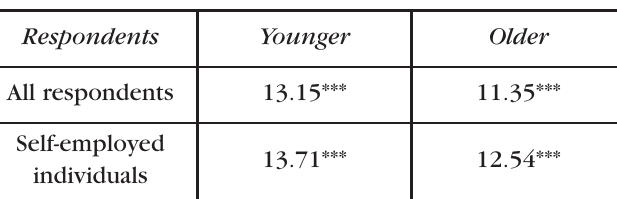
Table 8. Average Number of Years of